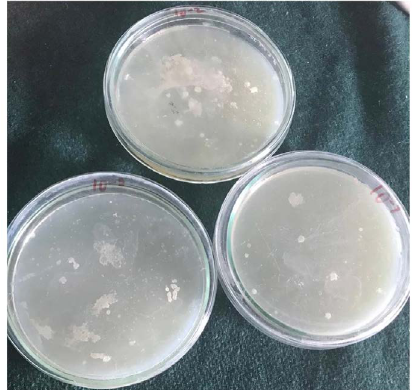
Fig. 3. Control plates of Brain heart infusion media without aspargine and phenol red indicator